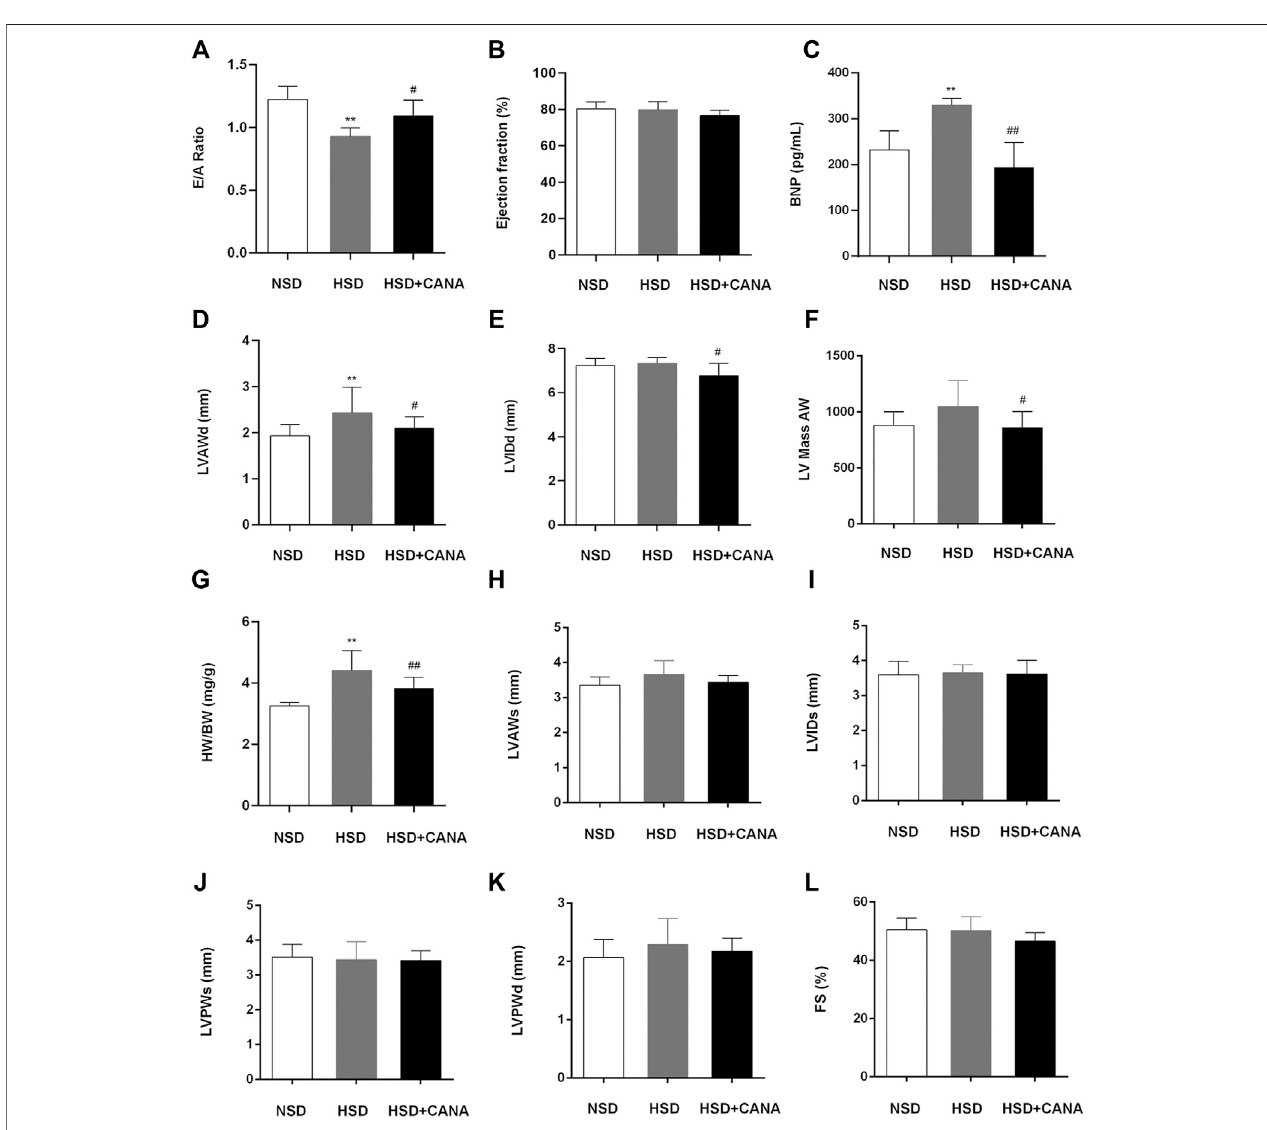
FIGURE 2 | Effect of CANA on cardiac function. (A) Evaluation ofthe ratio of peak E to peak A (E/A) by echocardiography; (B) Left ventricular ejection fraction (EF); (C) Concentration of BNP in the serum; (D) Left ventricular anterior wall end diastole (LVAWd); (E) Left ventricular internal diameter end diastole (LVIDd); (F) Left ventricular mass AW; (G) Heart-to-body weight ratio (HW/BW); (H) Left ventricular anterior wall end systole (LVAWs); (I) Left ventricular internal diameter end systole (LVIDs); (J) Left ventricular posterior wall end systole (LVPWs); (K) Left ventricular posterior wall end diastole (LVPWd); (L) Fractional shortening (FS); CANA, canagli fl ozin; NSD, normal-salt diet; HSD, high-salt diet. ** p < 0.01 vs. NSD. # p < 0.05, ## p < 0.01 vs. HSD.